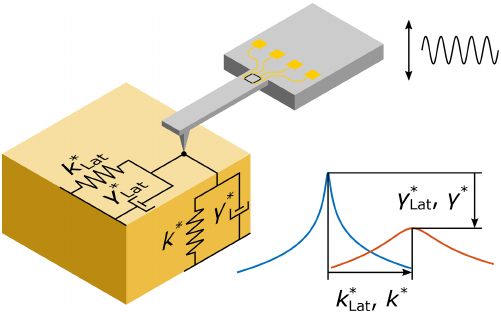
Figure 2. Schematic of the tip–surface interaction during out-of- plane bending vibration of the cantilever. The interaction is split into normal forces and lateral forces (with respect to the surface of the sample). Elastic behavior of the sample is modeled by the con- tact stiffnesses k ∗ and k ∗ , respectively, while the viscous behavior Lat is modeled by the contact damping parameters γ ∗ and γ ∗ , respec- Lat tively. Increasing the stiffness will lead to an increase in resonance frequency, while increasing the damping will reduce the resonance quality factor. Representation inspired by Kocun and Ohler